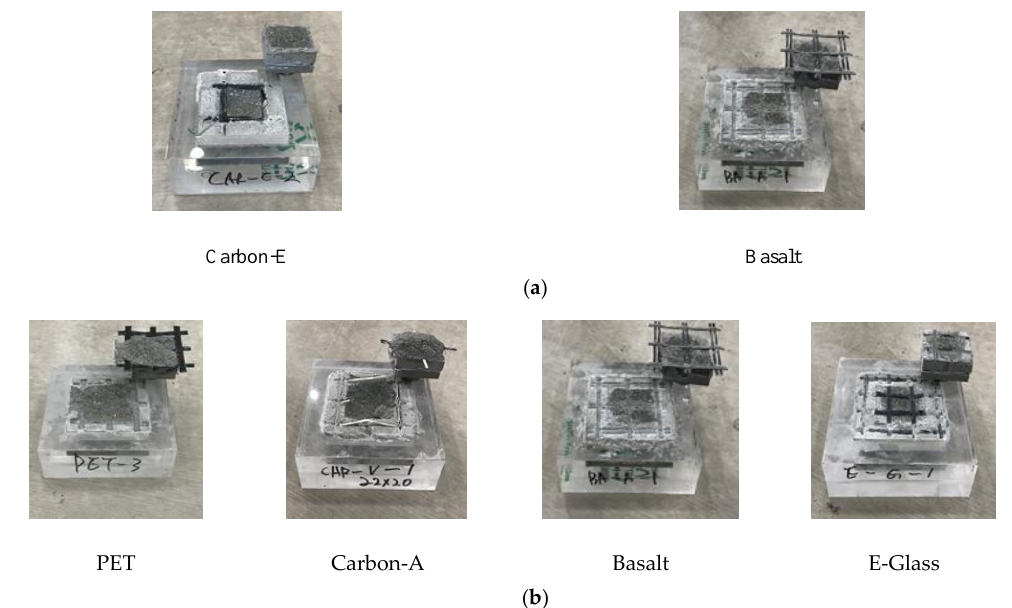
Figure 8. Failure of pull-out series: ( a ) textile-type failure; ( b ) weaving-type failure.